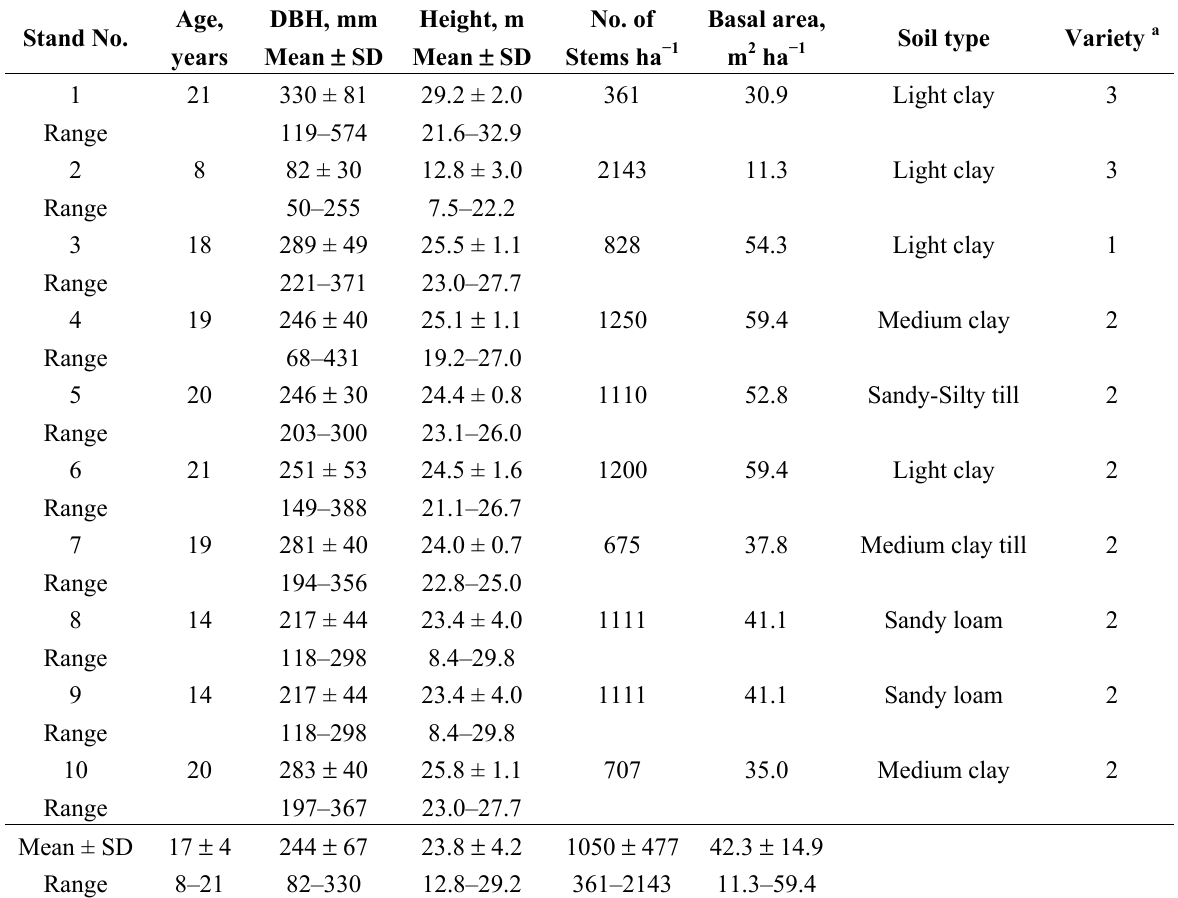
Table 1. Properties of the hybrid poplar stands prior to clear